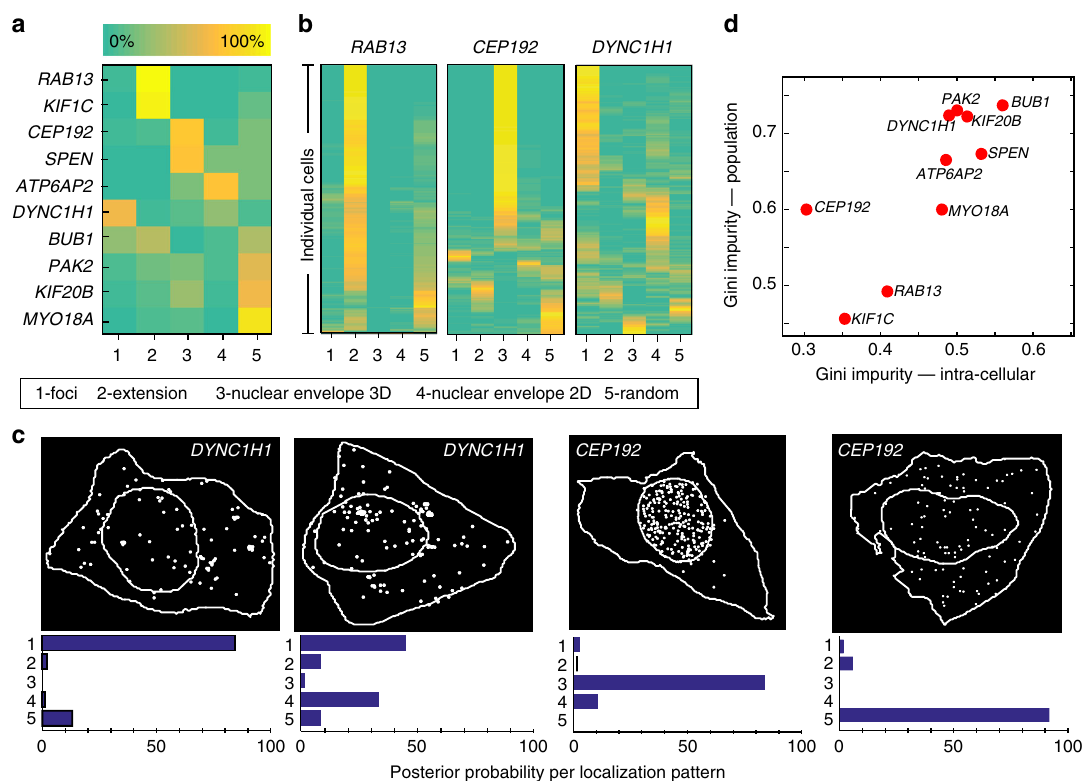
Fig. 4 Supervised analysis of experimental data reveals localization heterogeneity. a Results of supervised random forest classi fi cation trained on 5 classes (mRNA foci, nuclear envelope in 2D or 3D, cell extension and random) from simulated data. Heatmap shows the majority voting results for all cells of each gene. Among the simulation classes, “ Nuclear envelope 3D ” is closest to the experimental class intranuclear. b Posterior probabilities for single cells of the indicated genes. c Example of individual DYNC1H1 cells and their posterior probability. d Scatter plot of Gini impurity calculated on average probability of a gene (population) against the average Gini impurity of individual cells of a gene